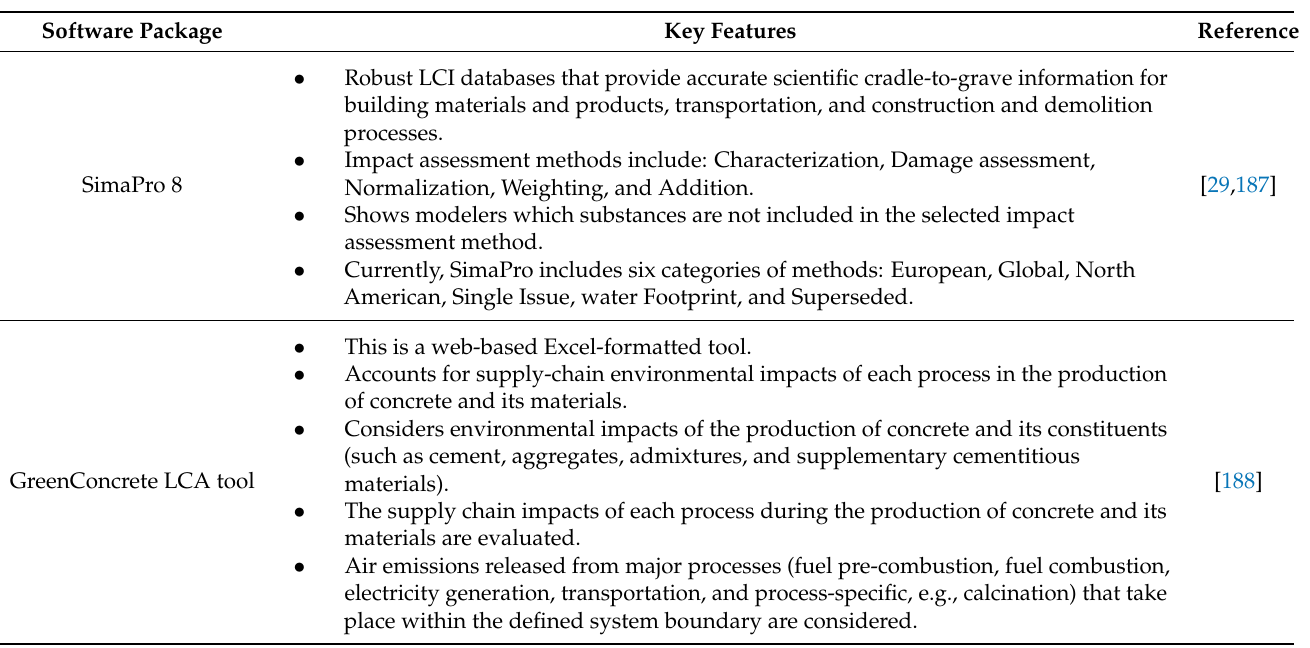
Table 14. Key LCA software summary for package